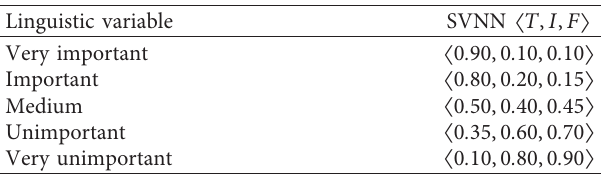
Table 2: Linguistic variable for relative importance weight of DM